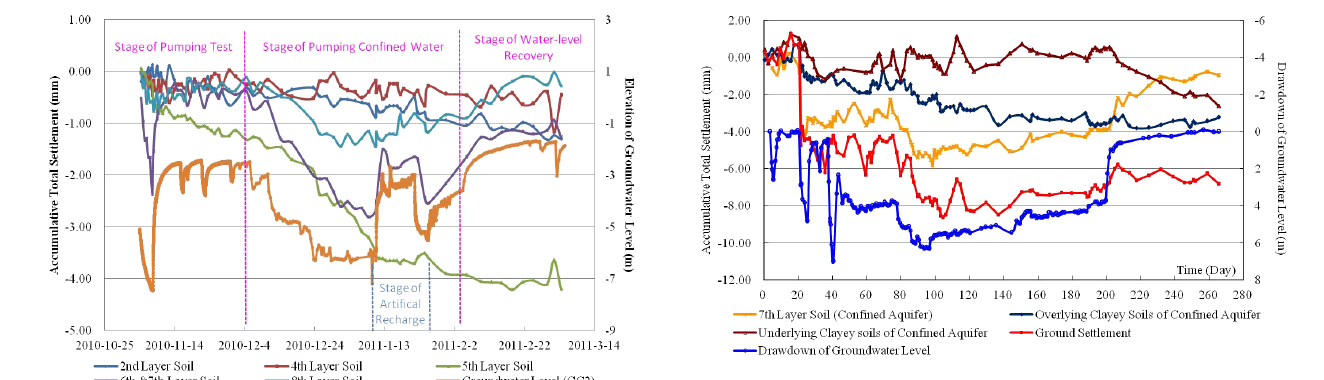
Figure 4. Duration graphical chart of soil laminar settlement and confined aquifer head drop depth at the point of 3 times the depth of foundation